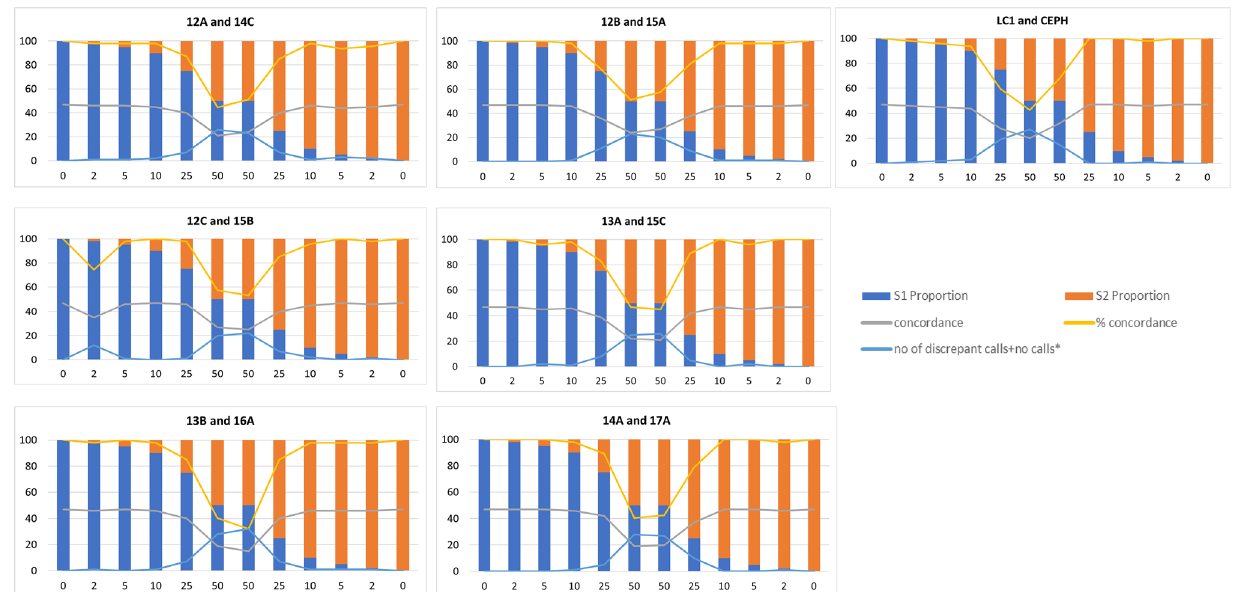
Figure 2. Concordance calls across the seven pairs of samples tested on the Agena iPLEX Sample ID Plus panel. The grey line indicates the concordant SNPs (N); the yellow line indicates the concordant SNPs (%); the blue line indicates the number of discordant plus no calls. Sample S1 is used as reference for the mixtures with S1 as the major component (blue) and the first 50:50 mixture; sample S2 is used as reference for the second 50:50 mixture and for the mixtures with S2 as the major component (orange).